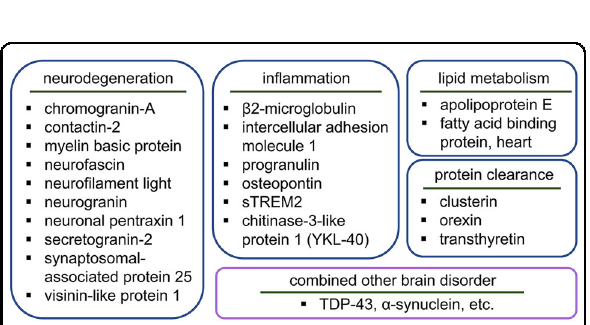
Fig. 2 Overview of candidate non-A β and non-tau fl uid